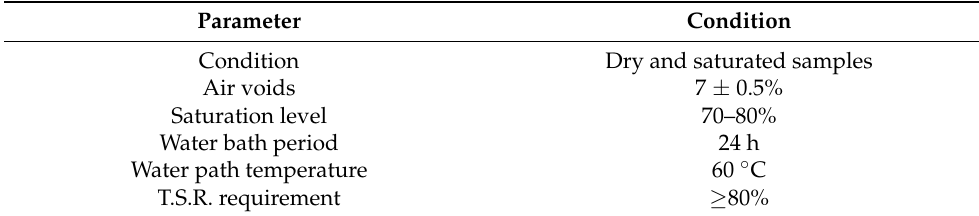
Table 10. Moisture sensitivity test